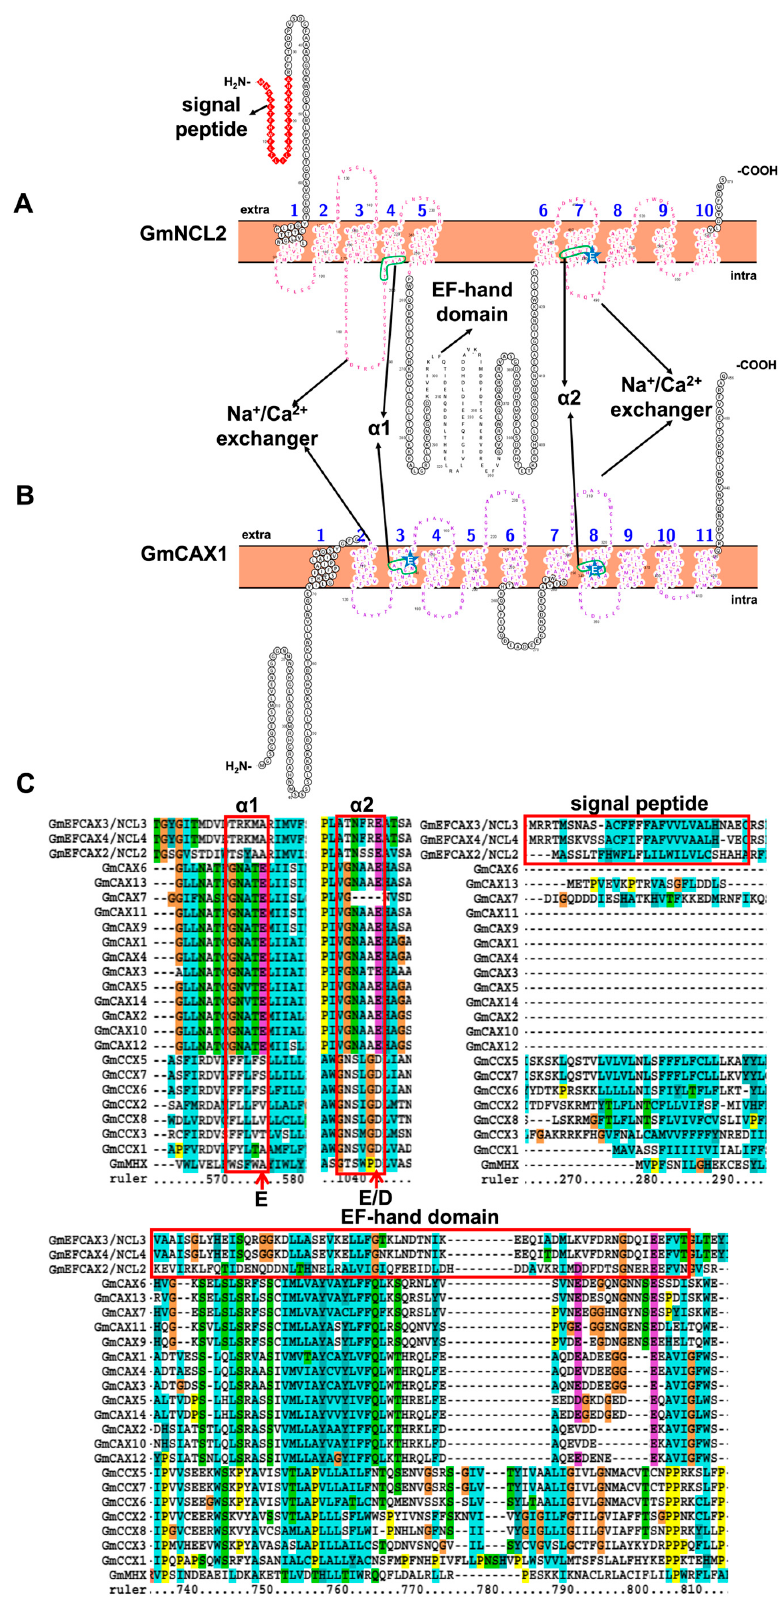
Figure 3. Topology model and homology analysis of soybean Ca 2+ /cation antiporter. ( A ) Topol- ogy model of Na + /Ca 2+ exchanger-like (NCL). ( B ) Topology model of Ca 2+ /H + exchanger